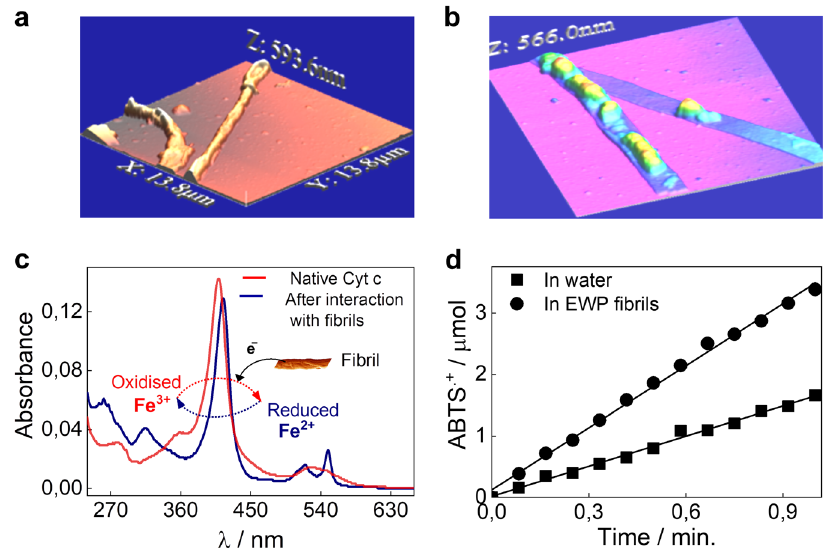
Fig. 8 Enzyme immobilization and activity assay. 3-D AFM images of EWP fi brils a without Cyt c and b with Cyt c attached to EWP fi brils. c UV – vis spectra of Cyt c before and after immobilization with fi brils. d Comparative activity of Cyt c in water and protein fi brils solution according to the formation of ABTS • + with time upon oxidation of ABTS as